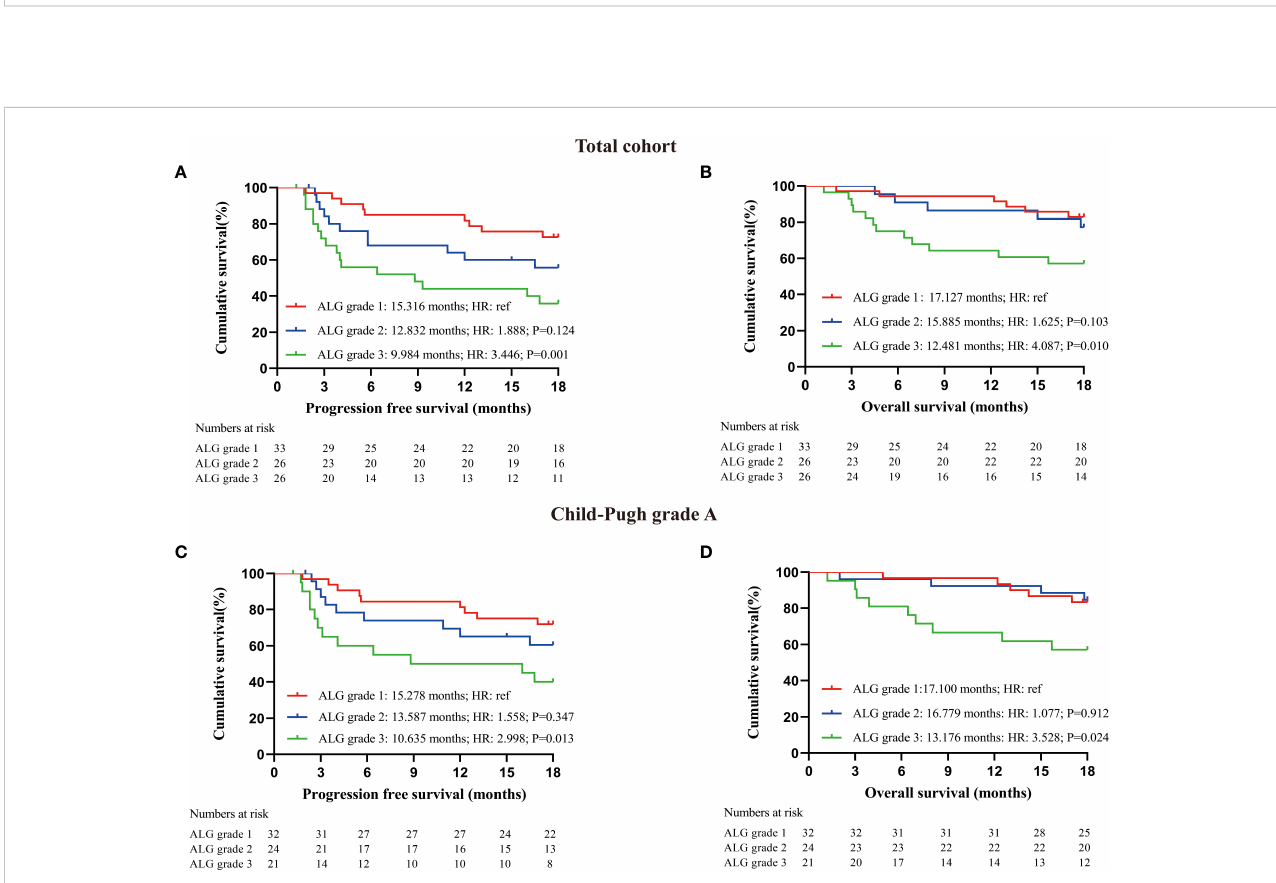
FIGURE 3 Prognostic analysis of patients receiving PD-1 inhibitors; (A) PFS of all enrolled patients with different ALG grade at baseline; (B) OS of all enrolled patients with different ALG grade at baseline; (C) PFS of patients with Child-Pugh grade A according to serum ALG grade at baseline; (D) OS of patients with Child-Pugh grade A according to serum ALG grade at baseline. Log-rank test was used to compare the prognostic differences between